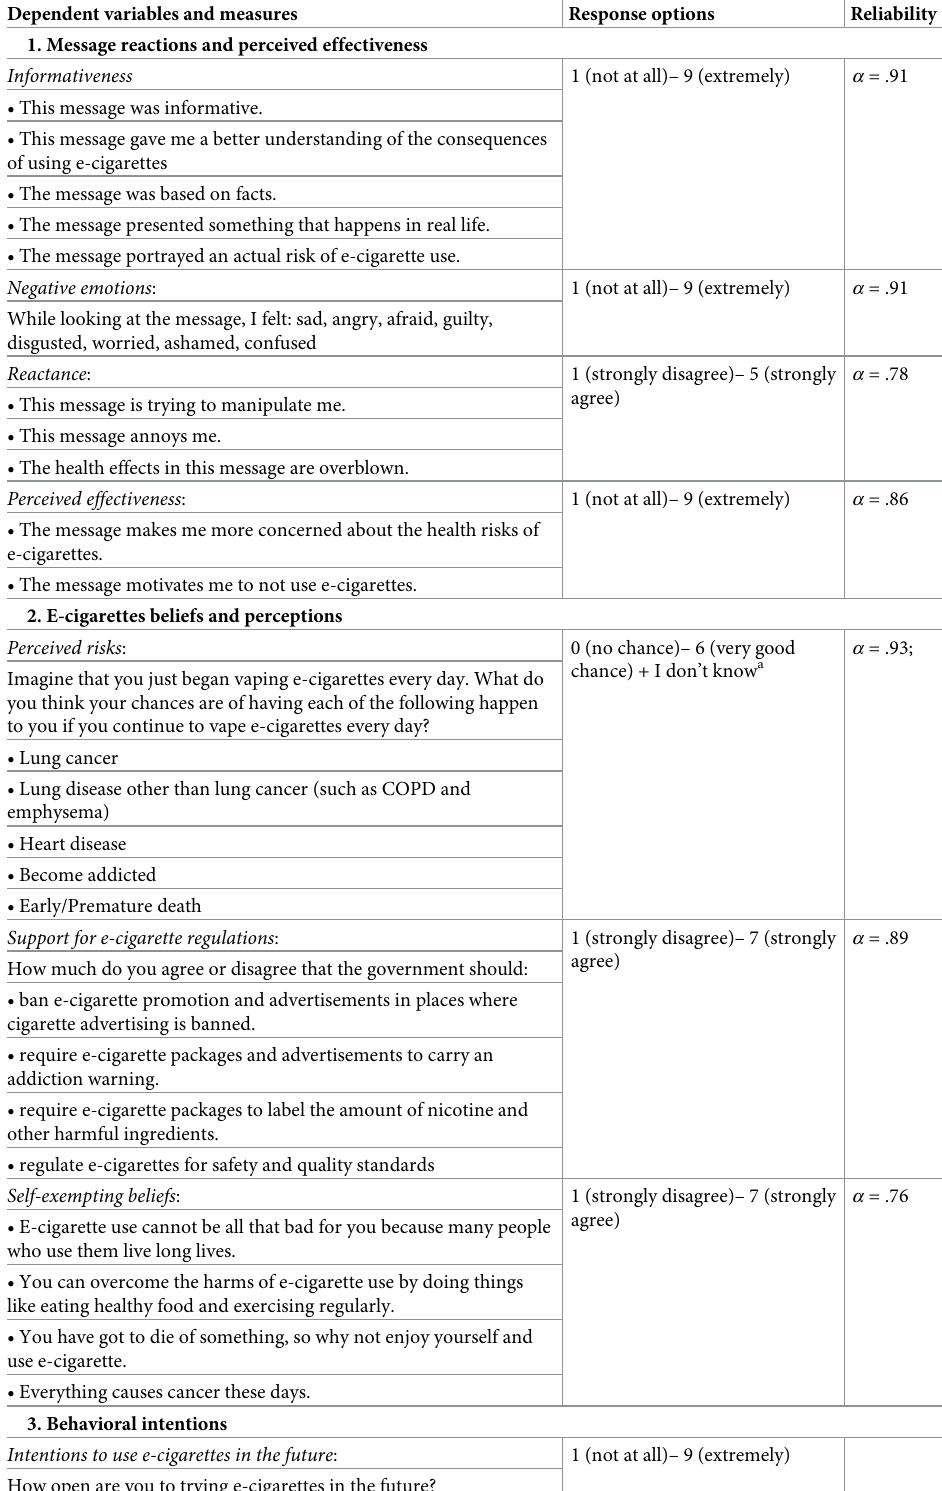
Table 1. Measures and definition of dependent